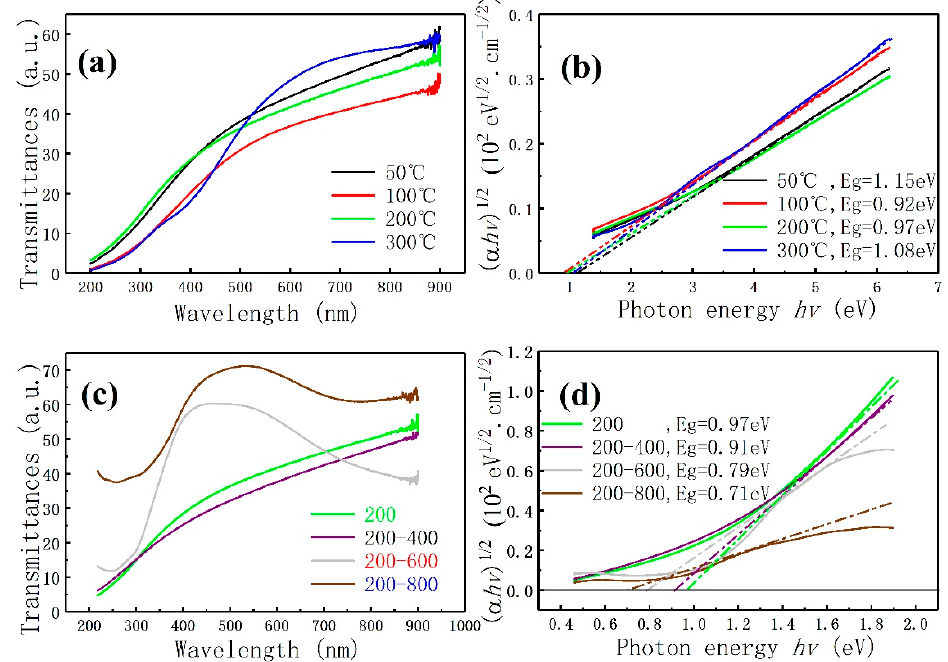
Figure 8. MoS 2 films prepared at different deposition temperatures: ( a ) visible light transmittance, ( b ) the determination of the optical band gap. MoS 2 films prepared at 200 °C annealing at different temperature: ( c ) visible light transmittance, ( d ) determination of optical band gap.